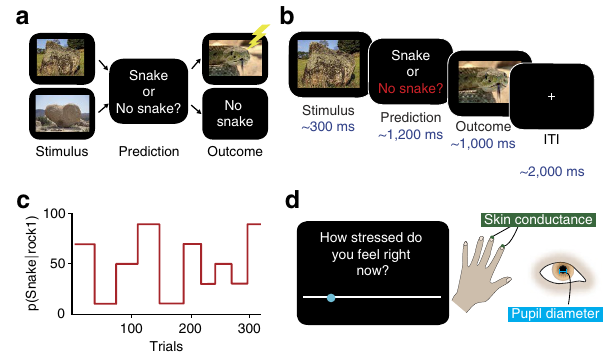
Figure 1 | Task structure and stress measures. ( a ) Learning task. Visual stimuli (rocks) were probabilistically associated with outcomes (snake or no snake). Subjects made a prediction of the outcome on each trial. The appearance of a snake was accompanied by the delivery of a painful electric shock. ( b ) Example trial. Here the participant incorrectly predicts no snake. Timing was jittered; see Methods. ( c ) The probabilities governing stimulus– outcome relationships shifted unpredictably over time, producing fluctuations in uncertainty. ( d ) Subjective stress ratings were collected every four to six trials. Measures of skin conductance ( n ¼ 45) and pupil dilatation ( n ¼ 22) were collected in some